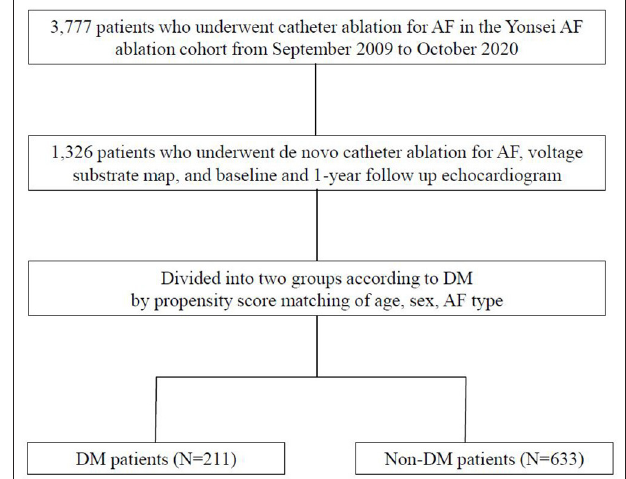
FIGURE 1 | Study flow chart of patient enrollment. AF, atrial fibrillation; DM, diabetes mellitus.